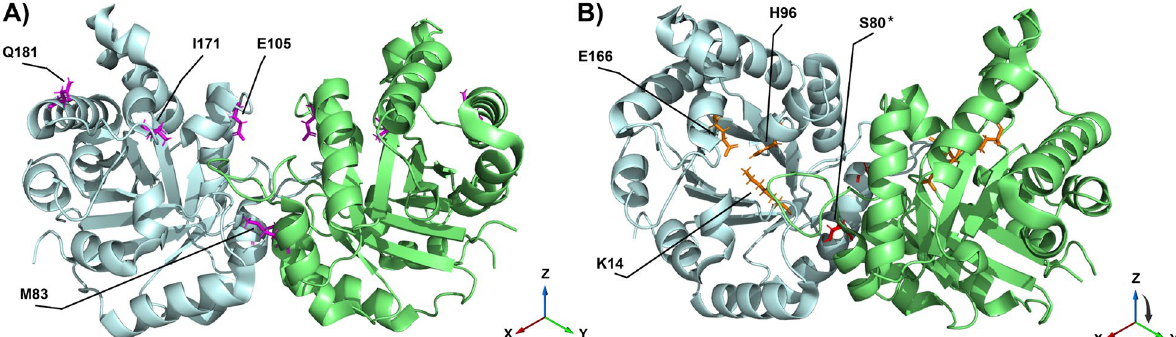
Fig. 1 Structure of the human TPI protein homodimer with selected residues displayed. A Several key amino acids (magenta) are labeled that cause or model disease. The TPI E105 substitution site, which is associated with nearly all cases of human TPI deficiency, is noted. Also noted are the TPI Q181 and TPI I171 mutation sites which only cause disease when paired with a TPI1 E105D allele. Finally, the TPI M83 mutation site in the human TPI protein, which corresponds to the Drosophila TPI sgk mutation site, is shown. Important to note is the proximity of both the TPI E105 and TPI M83 residues to the dimer interface. B Active site residues and the TPI S80 phosphorylation site. Active site residues TPI K14 , TPI H96 , and TPI E166 are displayed in orange. The TPI S80 phosphorylation site, which affects the nuclear localization of TPI, is displayed in red. The TPI S80 phosphorylation site is labeled on the opposite subunit as the active site residues are labeled. Figure created with the PyMOL Molecular Graphics System, Version 2.5.2, Schrödinger, LLC, using Protein Data Bank structure